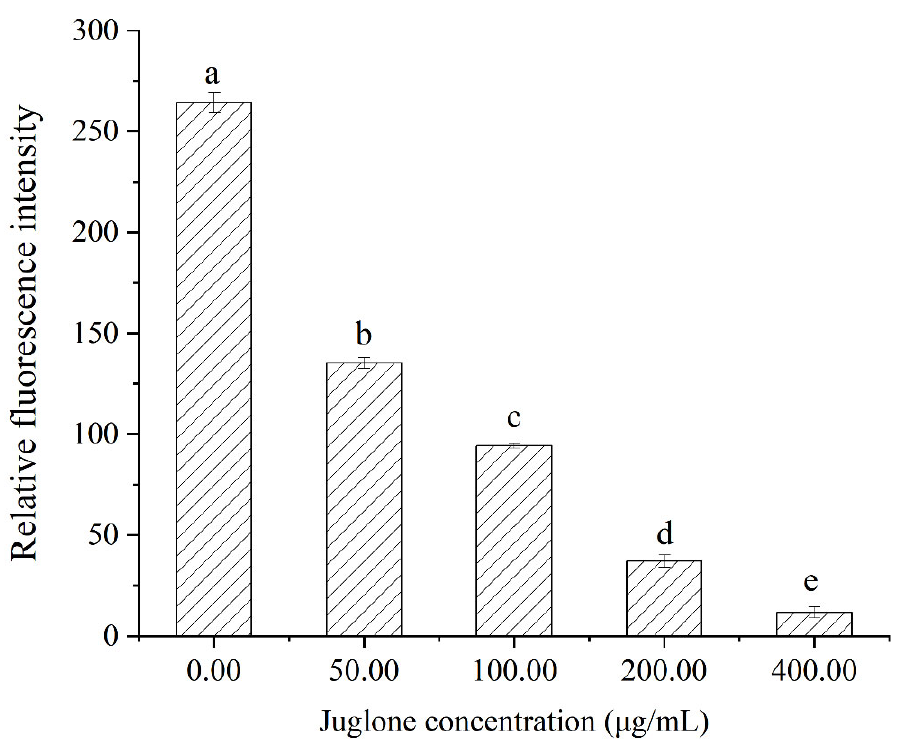
Figure 4. Effects of juglone on the membrane potentials of L. monocytogenes . Values represent the means of independent triplicates. Bars represent the standard deviation ( n = 3). Different letters denote significant differences ( p < 0.05).